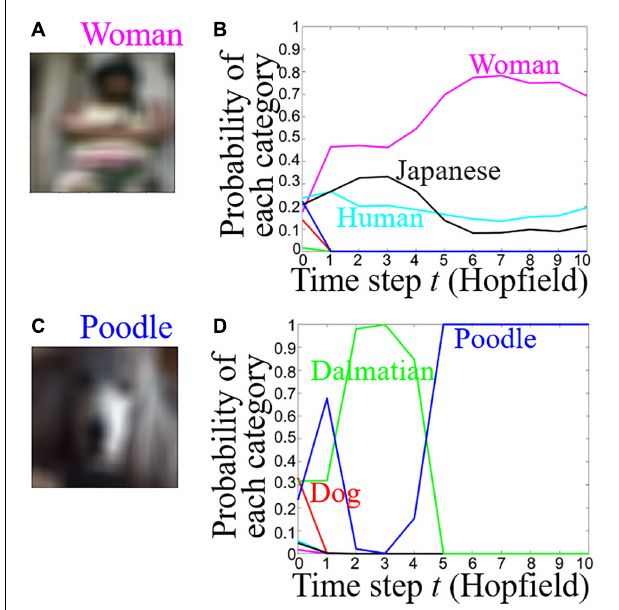
FIGURE 3 | Time course of the probability of each category for Woman and Poodle images with Gaussian noise. (A,C) Woman and Poodle images with Gaussian noise. (B,D) Time course of the probability of each category for Woman and Poodle images. Cyan: Human, magenta: Woman, black: Japanese, red: Dog, green: Dalmatian, blue: Poodle.